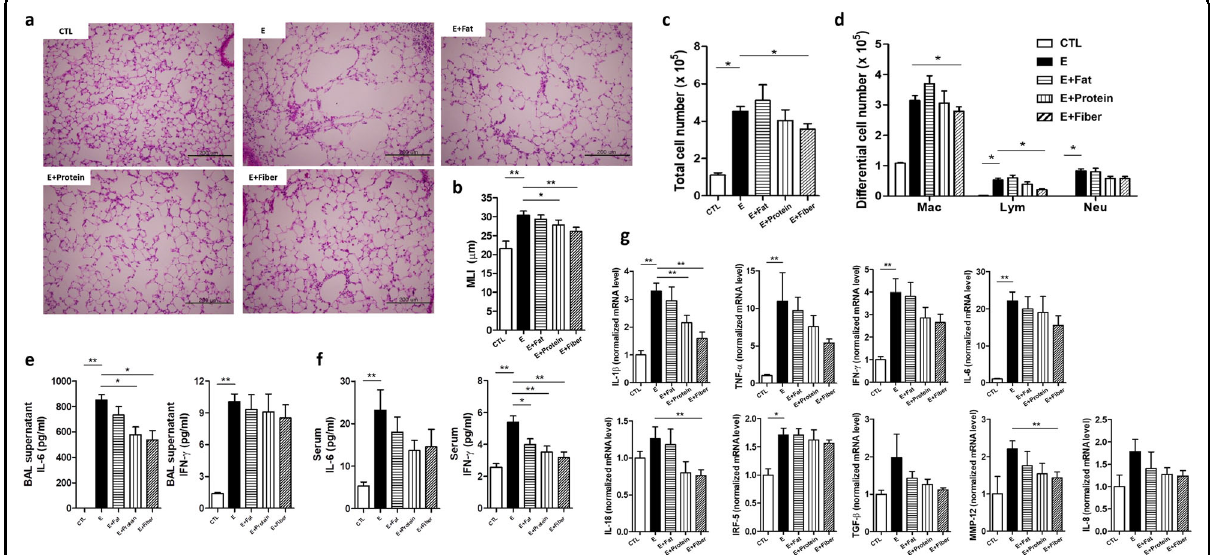
Fig. 2 Dietary modi fi cation alters in fl ammation and the degree of alveolar destruction (Experiment 2). a Representative H&E-stained lung tissues from mice in the control, emphysema, emphysema with high-fat diet, emphysema with high-protein diet, and emphysema with high- fi ber diet groups (magni fi cation: 200×). b The MLI of lung tissues from each group. c Total number of cells in the BALF in fi ltrating the airways. d Differential cell numbers of BALF in each group. e, f The levels of the cytokines IL-6 and IFN- γ in the BALF ( e ) and serum ( f ) measured using ELISA. g The relative mRNA levels of IL-1 β , TNF- α , IFN- γ , IL-6, IL-8, IL-18, IRF-5, TGF- β , and MMP-12 in lung tissues ( n = 4 control mice, n = 6 emphysema mice, n = 6 emphysema with high-fat diet mice, n = 6 emphysema with high-protein diet mice, and n = 6 emphysema with high- fi ber diet mice). Values are expressed as the mean ± SE. * P < 0.05 and ** P < 0.01. CTL control, E